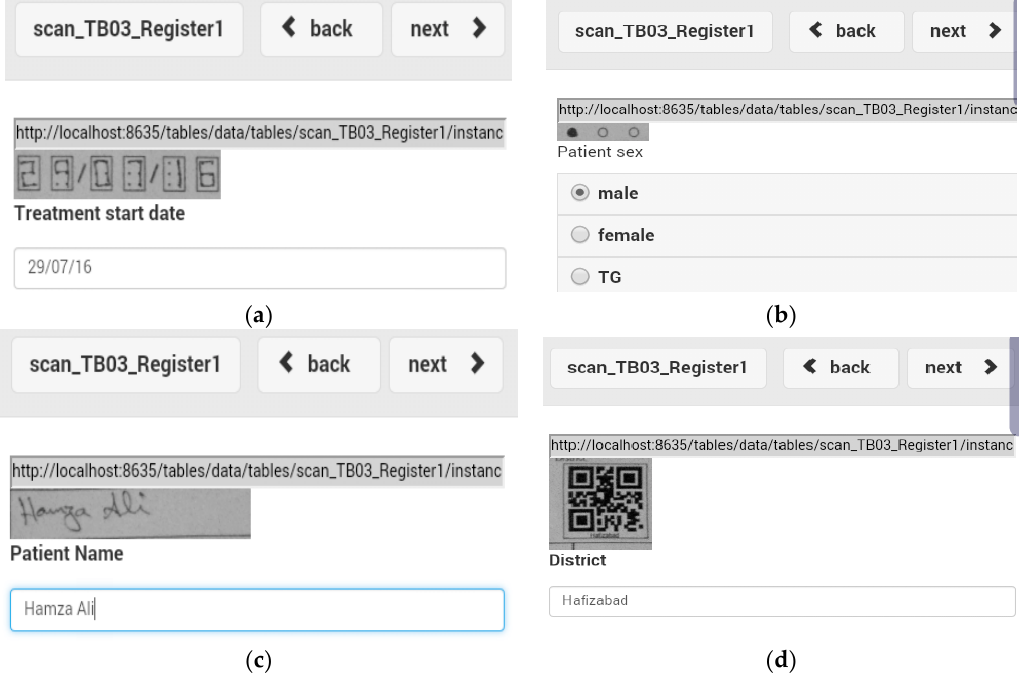
Figure 3. Formats of data fields on ODK Scan ‐ compatible TB03 form. ( a ) Machine ‐ readable structured number boxes; ( b ) machine ‐ readable fill ‐ in bubbles; ( c ) user transcribed text field; ( d ) machine ‐ readable QR code.